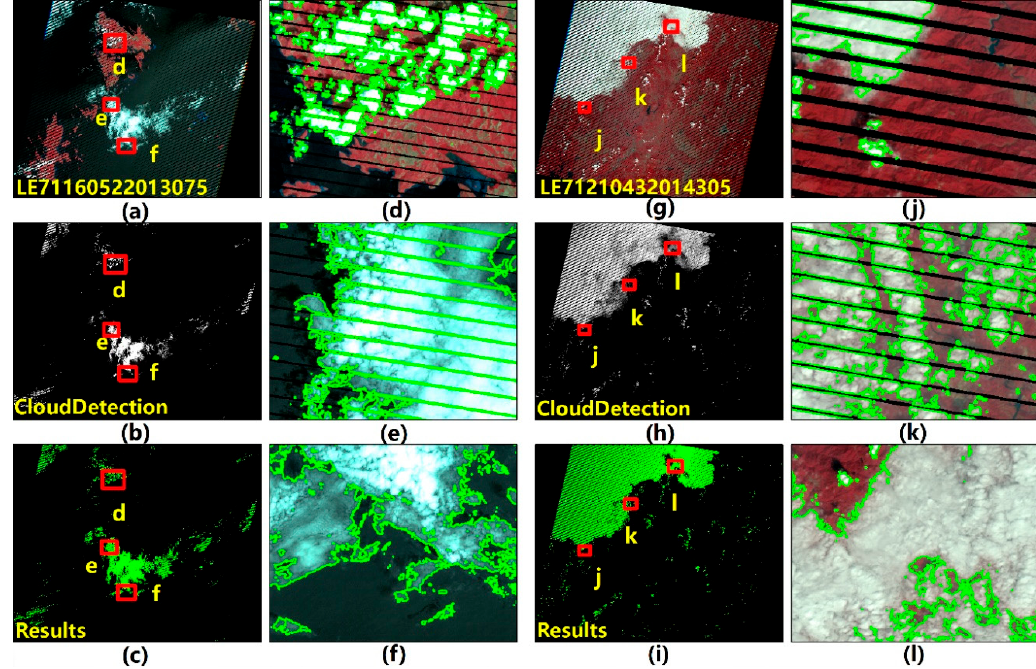
Figure 8. The original map (a, g) and the cloud detection results (b, c, h, i) obtained using the EN- Clustering method, for two selected Landsat ETM+ images. ( a ) ETM+ data acquired on March 17, 2013; ( g ) ETM+ data acquired on November 1, 2014. (d, e, f) and (j, k, l) present the magnified versions of the original data (a, g).